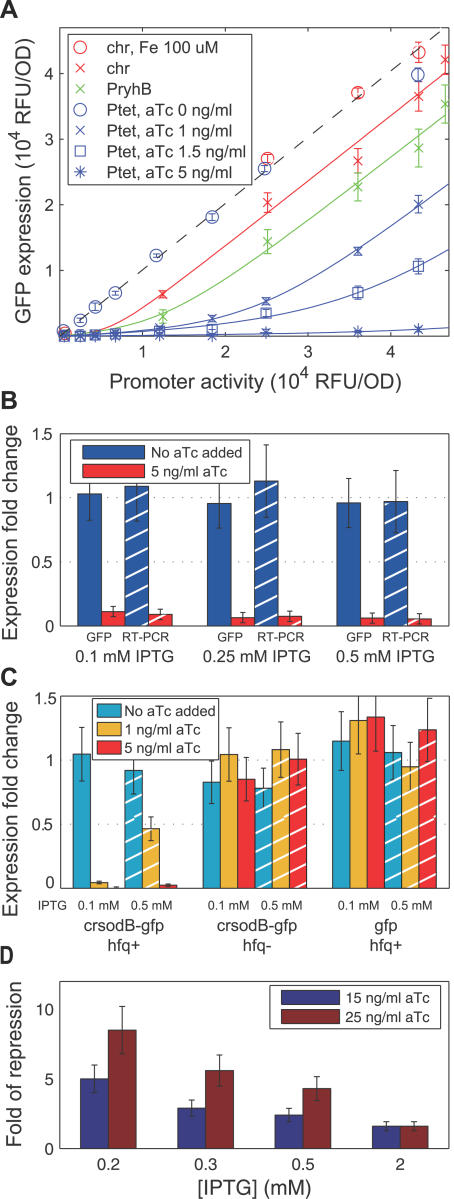
Threshold-Linear Response of a Reporter Target of RyhB(A) GFP expressions of various rhyB+ strains (red: strain ZZS22, green: ZZS24, blue: ZZS23) are plotted against the promoter activity, defined as the GFP expression of the ryhB
− strain (ZZS21) grown in identical medium (see Table 2 for information on the strains). Different promoter activities were obtained by varying IPTG concentration in the media (for example, the blue symbols were measured at 0, 0.05, 0.15, 0.2, 0.25 0.3, 0.4, 0.5 mM IPTG; see Figure S3). The curves are obtained from a single parameter fit of the data to the steady-state solution (Equation 2), as explained in the text and Table S1.(B) Ratio of GFP expression in the ryhB+ strain ZZS23 (harboring PLtet-O1:ryhB) and the RyhB-less strain ZZS21 measured through GFP fluorescence (solid bars) and RT-PCR (striped bars), for two different levels of aTc (blue and red) and three different levels of IPTG. In each case examined, the fold-change in GFP expression corresponded well to the fold-change in mRNA level.(C) Different RyhB levels (synthesized from PLtet-O1
:ryhB driven by different levels of aTc) do not significantly change GFP expression in hfq
− strains (middle group), or when crsodB-gfp is replaced by a gfp with a short 5′-UTR (right group). GFP fluorescence was measured in hfq
− strains that express a plasmid-borne target (PLlac-O1:crsodB-gfp) with (ZZS23q) or without (ZZS21q) plasmid-borne RyhB. The ratio between the two at different levels of inducers is plotted in the middle group of bars. Similarly, GFP fluorescence was measured in strains carrying the pZE12G plasmid, in which the gfp structure gene with a short 5′-UTR is placed immediately downstream of the promoter, with (ZZS13) or without (ZZS11) plasmid-borne RyhB. The ratio between the two is plotted in the right group of bars. For comparison, data for the isogenic hfq+ strains with the crsodB-gfp reporter are taken from (A) and replotted in the same format as the left group.(D) The fluorescence levels of cells expressing GFP by PLlac-O1:crsodB-gfp inserted chromosomally at the attP site was measured by flow-cytometry for strains ZZS43 (no ryhB), ZZS41 (plasmid-borne PLtet-O1:ryhB), and ZZS01 (which contained no gfp gene). The latter was used to quantify the background fluorescence level. The fold of repression (vertical axis), is defined as [fluorescence(ZZS41) − fluorescence (ZZS01)]/[fluorescence (ZZS43) − fluorescence (ZZS01)]. The data show that the repression effect of RyhB is reduced at higher levels of IPTG, corresponding to larger transcription rates of the target. For the ease of comparison, the GFP fluorescence data of (A) is replotted in the same manner in Figure S4, where similar behavior is seen. These results show that the nonlinear effect of RyhB is also exhibited by a chromosomally encoded target.